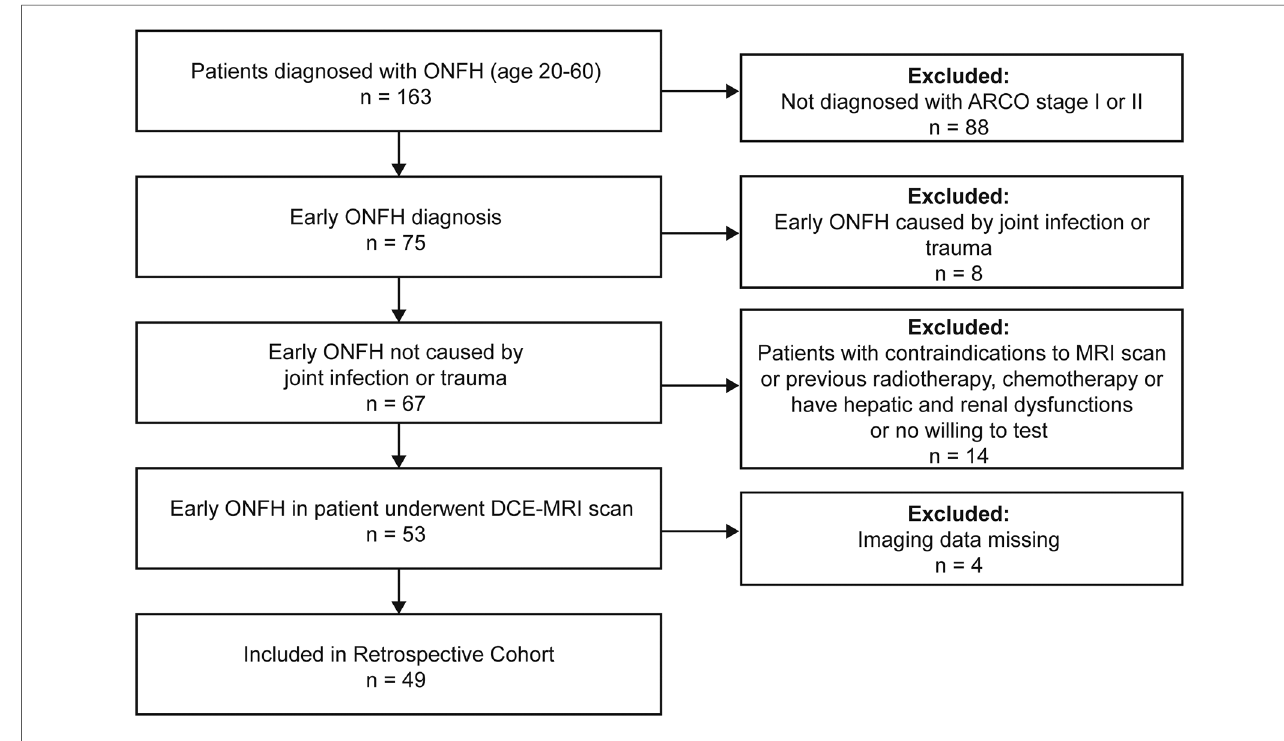
FIGURE 1 A fl ow diagram of included and excluded